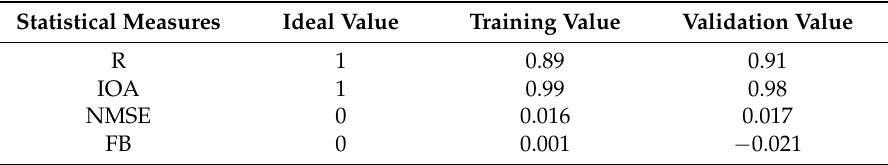
Table 16. Statistical performance measures for ANN–MLP